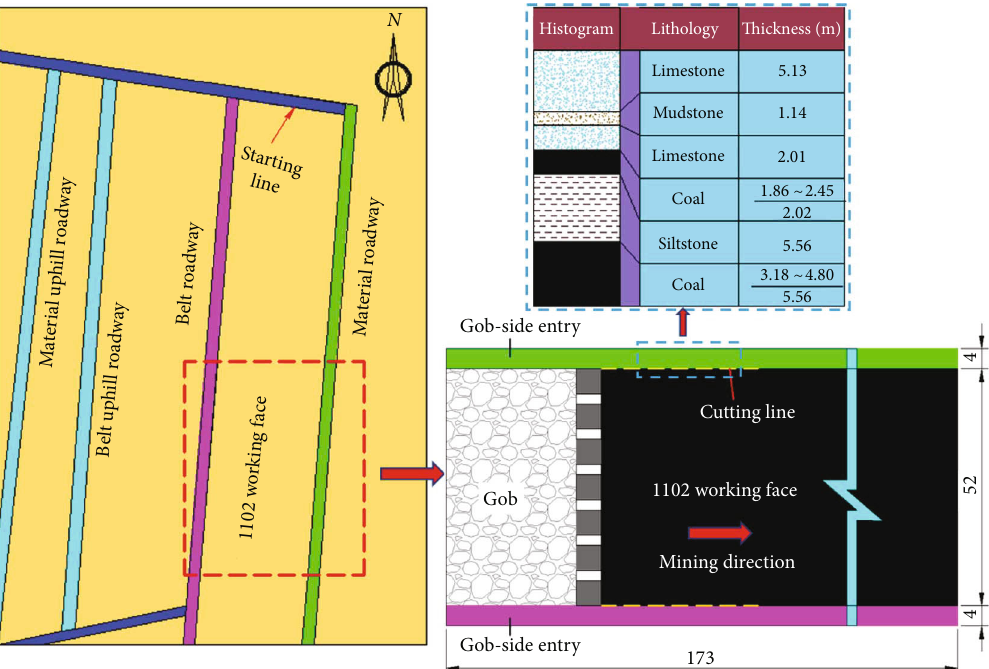
Figure 11: Plan view of 1102 working face and columnar view of roof and fl oor